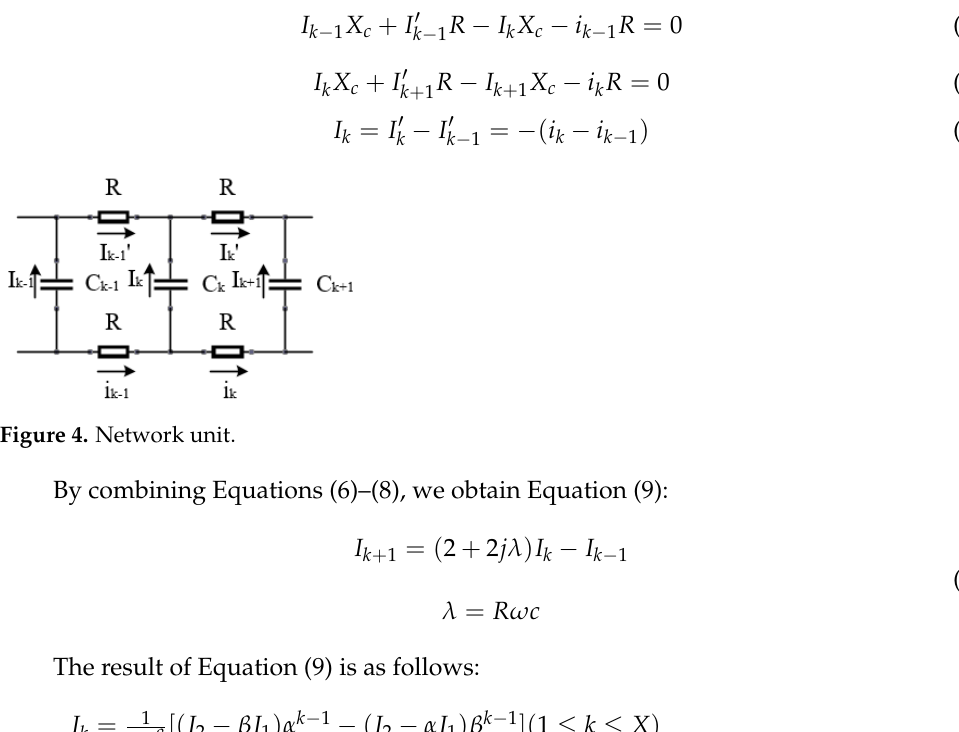
Figure 4. Network unit.